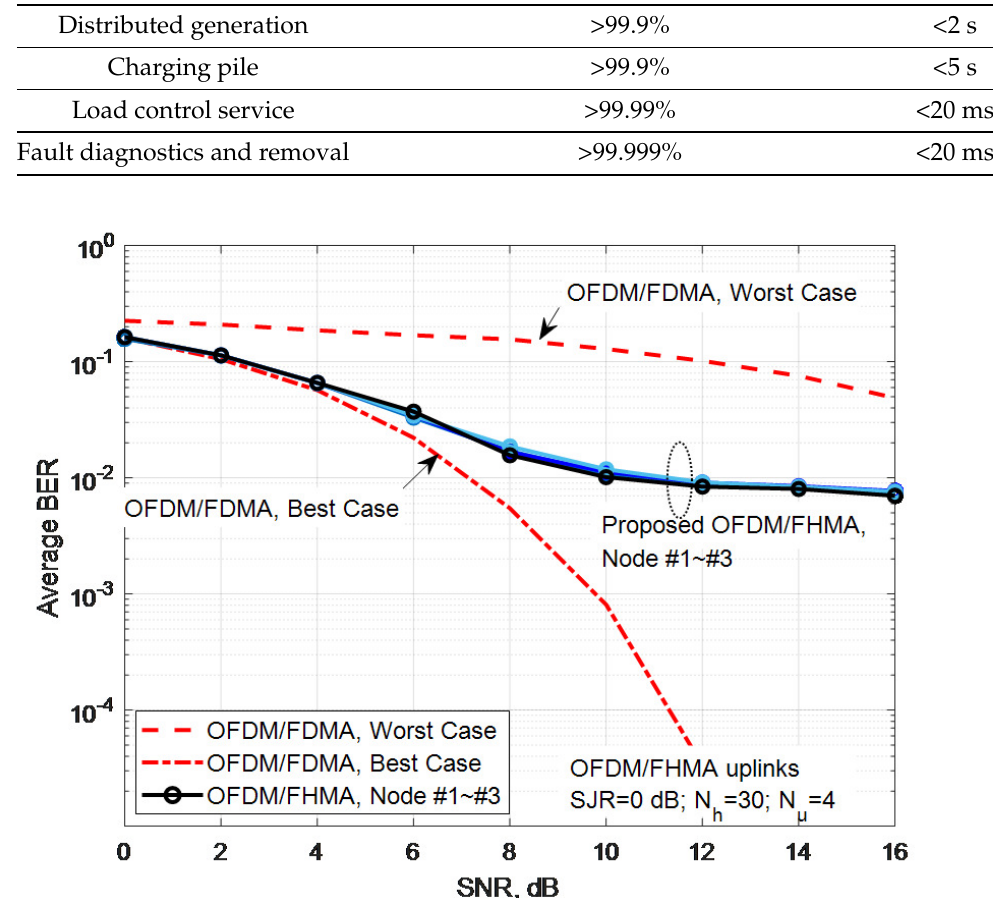
Figure 5. The reliability comparisons between the proposed system and the traditional